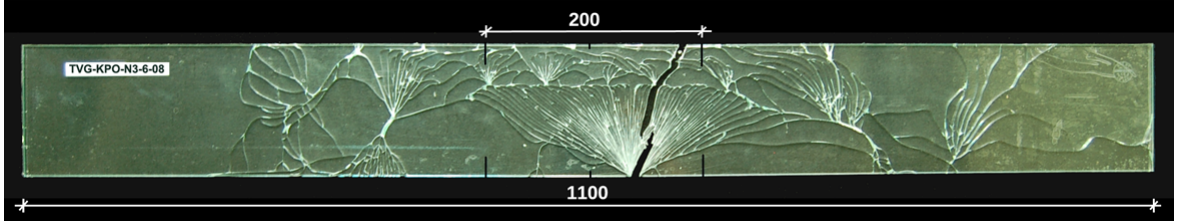
Fig. 8 Typical fracture pattern of heat strengthened glass (1100 x 125 x 6 mm³)